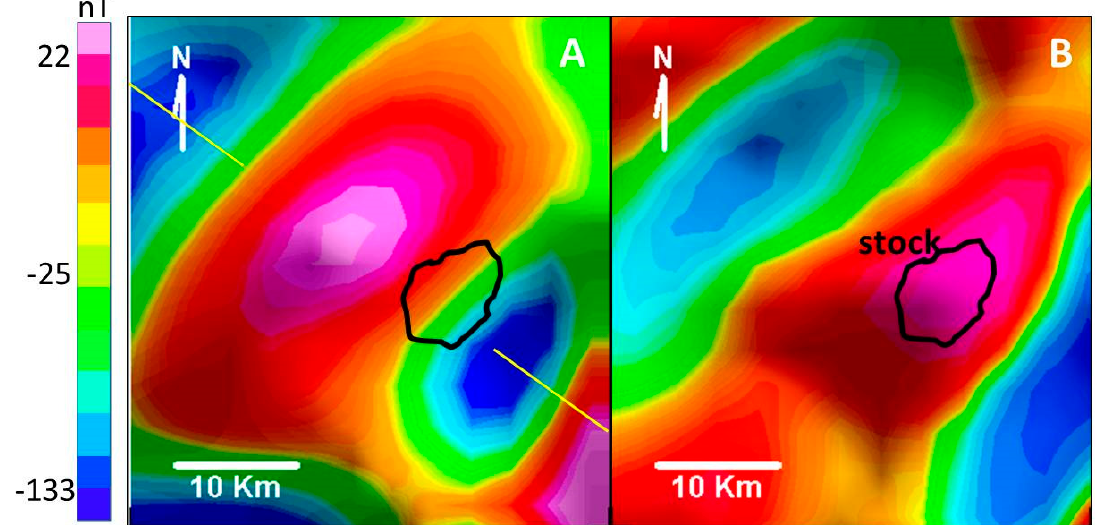
Figure 8. ( A ) Detailed map of the total field magnetic anomaly located at the SE of the Jupiter structure. The yellow straight line marks the map location of the modeled section (Figure 7). Note its high amplitude (greater than 150 nT) associated with a shallow localized source. ( B ) Derivative map of the total magnetic field anomaly showing the estimated location of the intrusive stock type body responsible for generating the total field magnetic anomaly. The top location of this body is defined by the black contour on the maximum values of the derivative. Note that the location of the intrusive body in the total field map is at the area between the maximum and minimum total field anomaly.